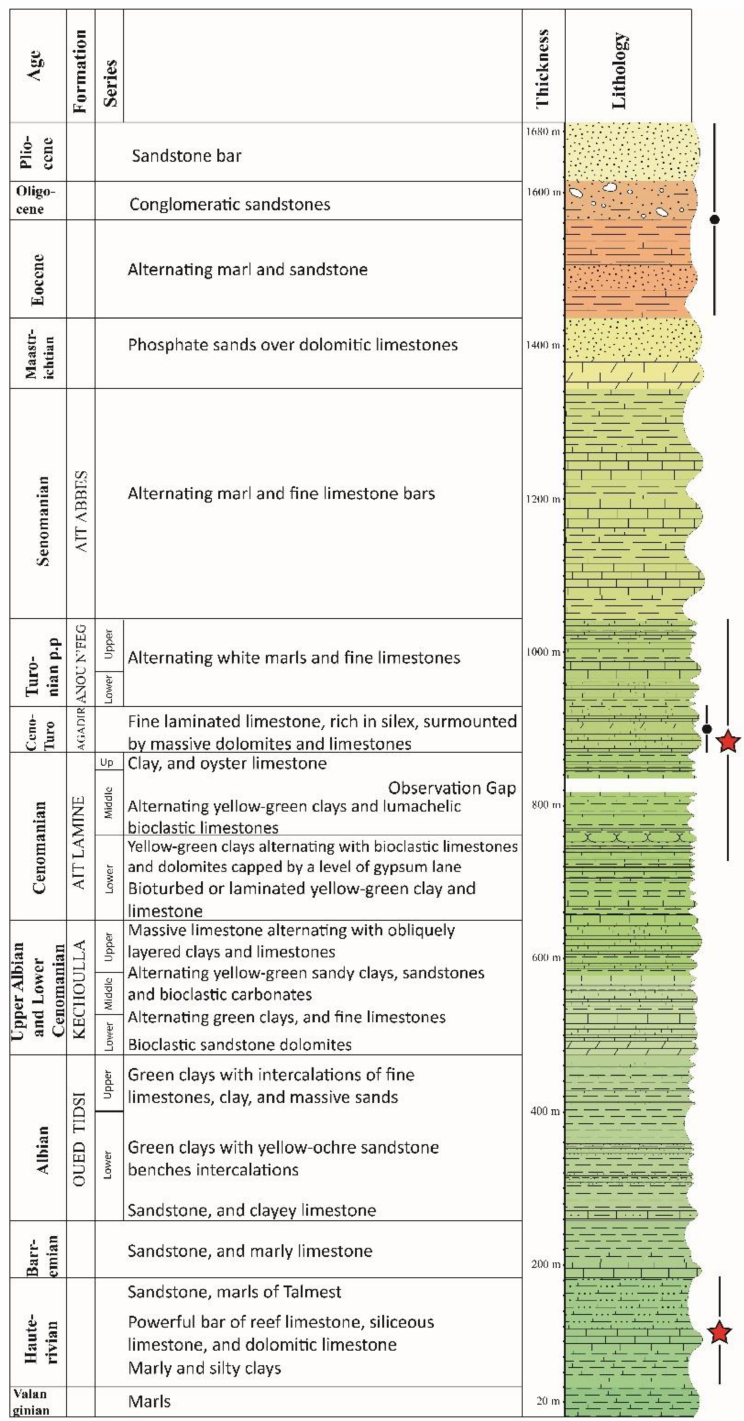
Figure 3. Lithostratigraphic log and aquifers in the study area (modified from